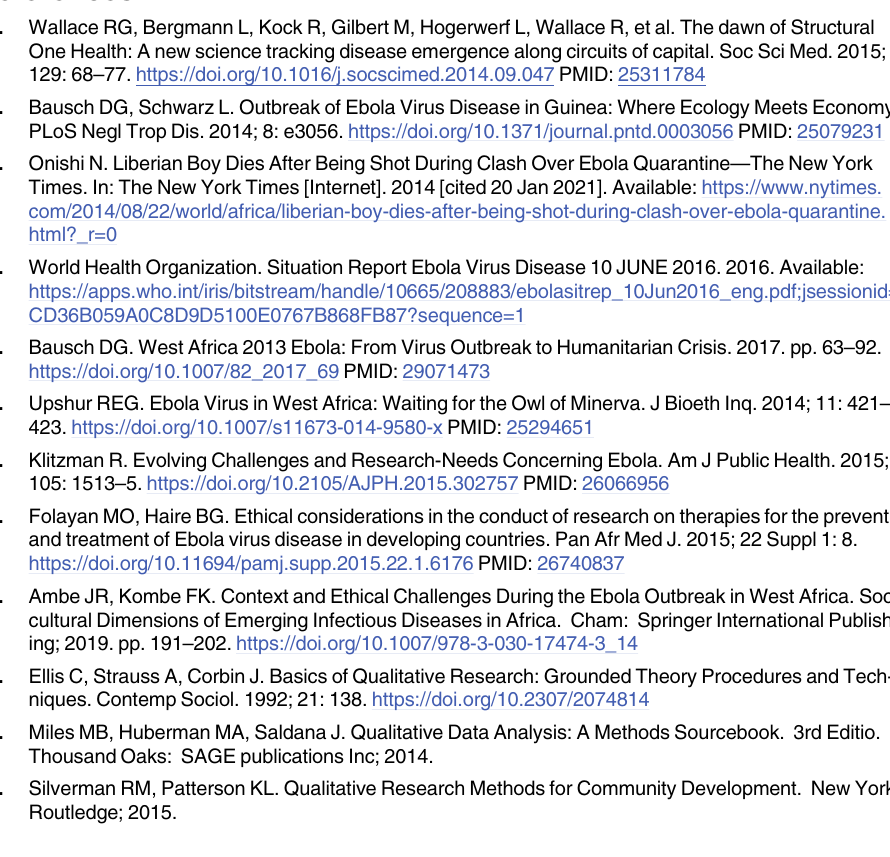
S2 Table. Mapping of open codes to axial